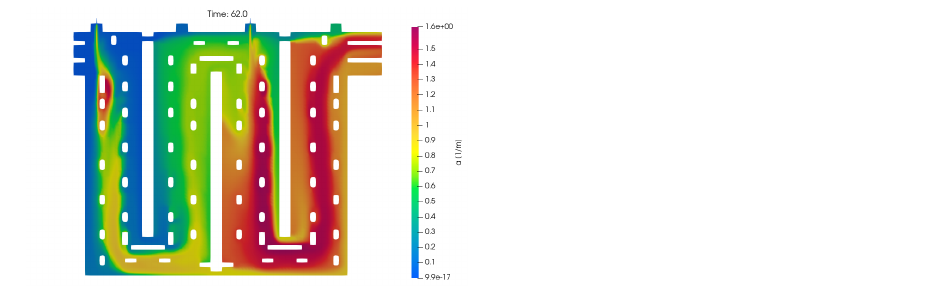
Figure 10. Computed thermal absorption coefficient κ on the symmetry plane after t = 62s of simulation time.